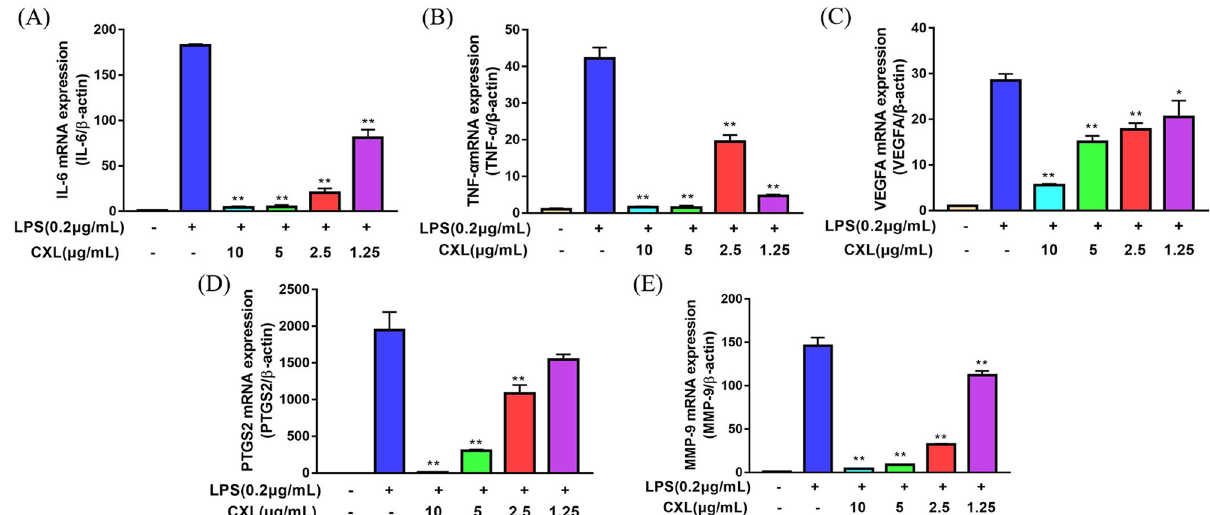
Figure 8. The mRNA levels of Chuan Xinlian extract on the RAW264.7 detecting using real-time PCR. ( A ) IL-6; ( B ) TNF-α; ( C ) VEGFA; ( D ) PTGS2; and ( E ) MMP-9 (compared with LPS group, * p < 0.05, ** p < 0.01, n = 3).